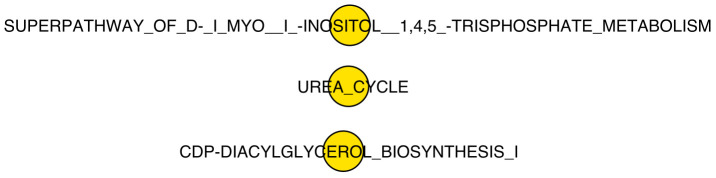
Enrichment map of top-scoring pathway features in tumour classifier example.The small number of nodes reflects the limited number of pathways provided to the toy example model, and also reduced parameter values for model building. See
Figure 5 for an example of a more informative enrichment map produced by running a real-world example.